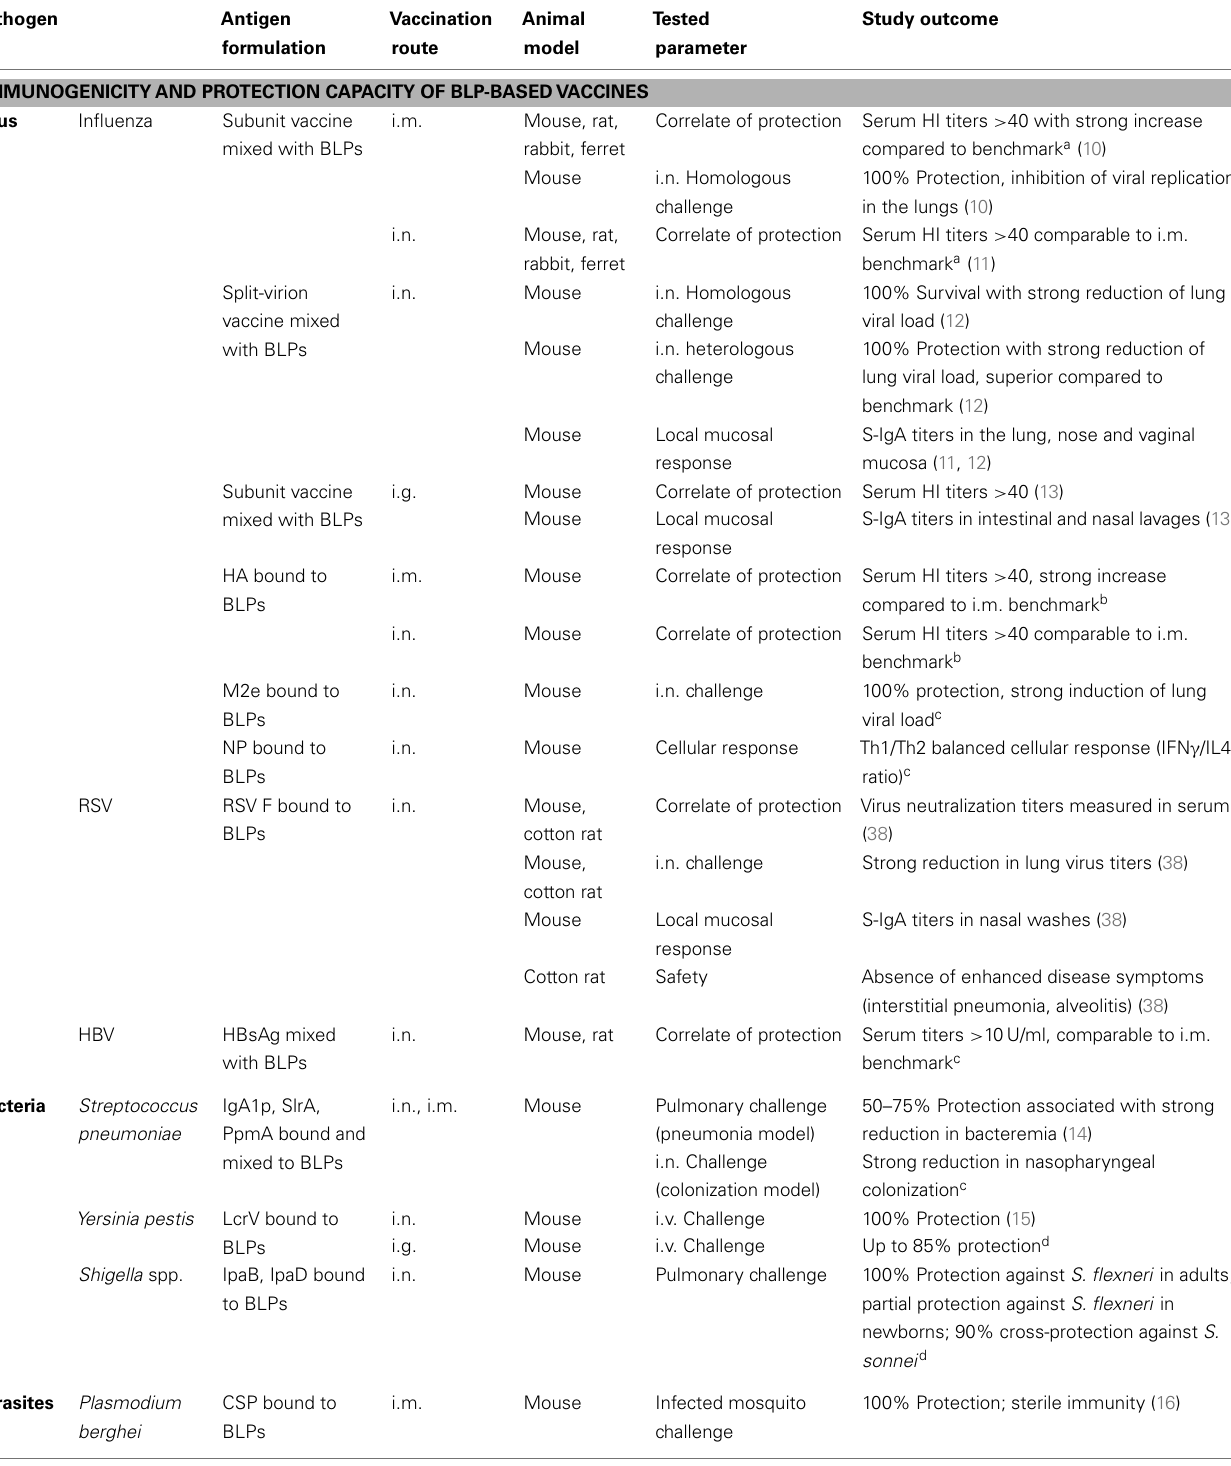
Table 1 | Overview of preclinical proof-of-concept studies performed using different BLP-based vaccine formulations.